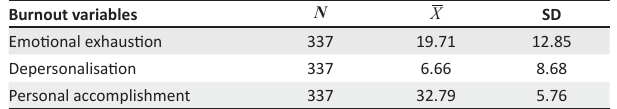
TABLE 3: Burnout results of the participants.